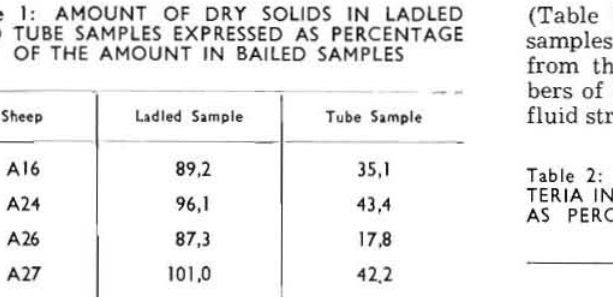
Table 2: NUMBERS OF TOTAL CULTURABLE BAC TERIA IN LADLED AND TUBE SAMPLES EXPRESSED AS PERCENTAGE OF THE NUMBERS IN SAilED SAMPLES ladled .. mpl ..